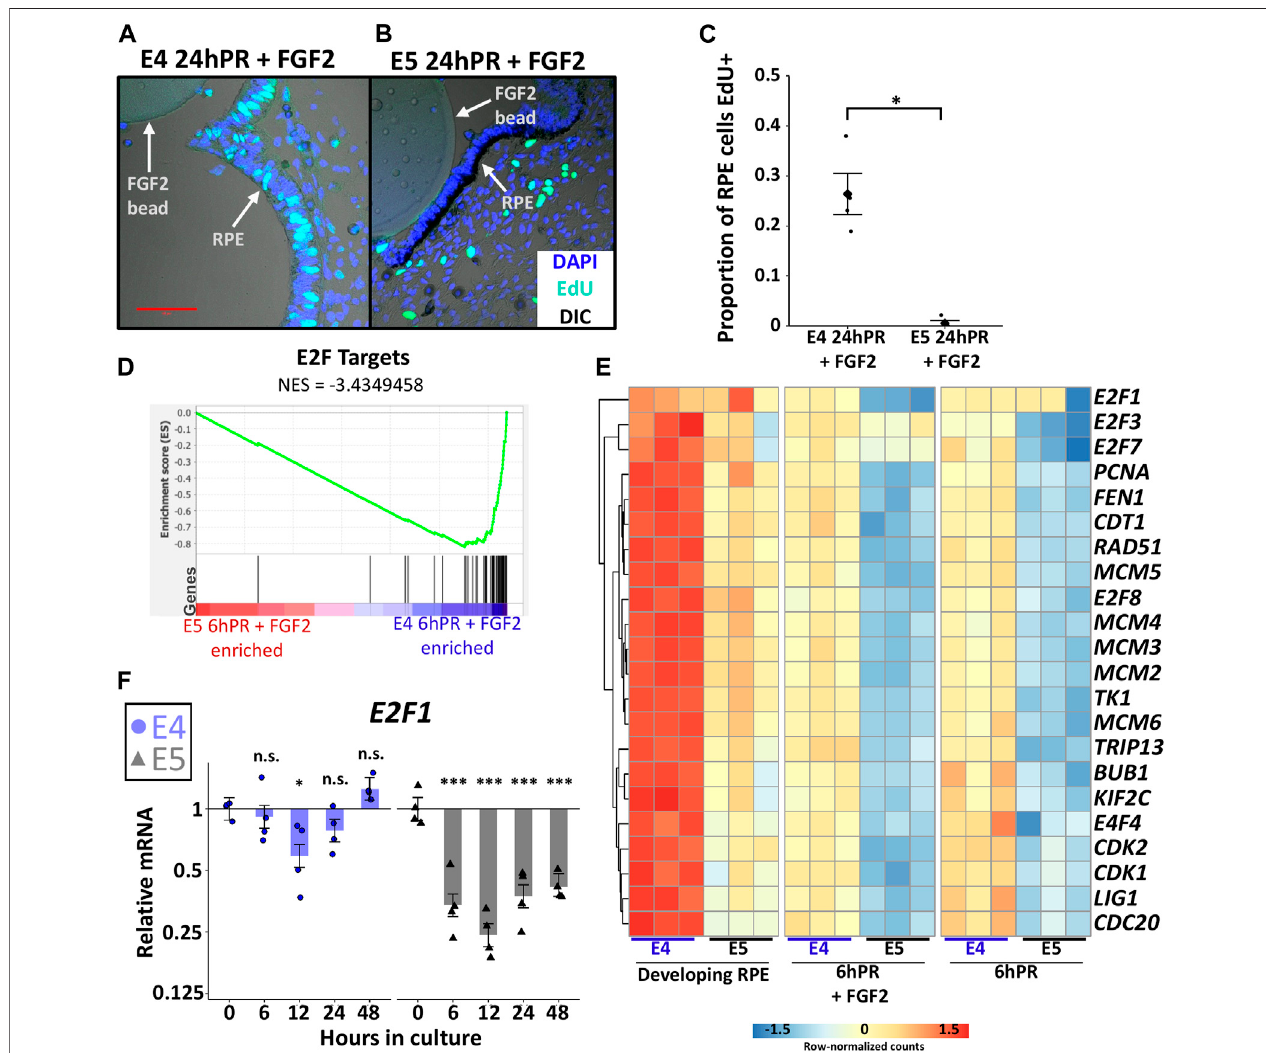
FIGURE 4 | Proliferation is tightly regulated across the window of RPE cell fate restriction. (A) EdU and DAPI fl uorescence staining of embryo sections collected 24 h PR (24hPR) and FGF2 treatment was performed at either E4 (A) or E5 (B) . Fluorescence channels are overlayed with differential interference contrast (DIC) image. 50 μ m scale bar in (A) applies to both panels. Chart displays the proportion of EdU positive RPE cells observed 24hPR + FGF2 at E4 and E5 (C) . Diamond represents meanproportion; asterisk(*)denotes Adj. p value < 0.05. (D) Geneset enrichment analysis(GSEA)wasperformedon normalized RNA-seq expression valuesfrom 6hPR + FGF2 E4 and E5 samples. A low normalized enrichment score (NES = − 3.4349458) for E2F targets indicates high enrichment in the E4 6hPR + FGF2 RPE and depletion from the E5 6hPR + FGF2 RPE. Each black vertical bar represents a gene in the pathway. (E) The row-normalized heatmap displays RNA-seq expression valuesforE2Ftargets genesandproliferation-associatedfactors. (F) RT-qPCRwasusedtomeasure E2F1 expression inE4and E5explantscultured inthepresenceof FGF2 and collected at the speci fi ed time points. Bar chart displays the average expression value, and the error bars represent standard error of the treatment mean basedonANOVA. Each dataset isnormalized tobasallevelsobservedat time0; y -axesarelog 2 -transformed.qPCRsigni fi cance:n.s.denotes notsigni fi cant,*denotes p -value < 0.05, ** denotes p -value < 0.01, *** denotes p -value < 0.001.